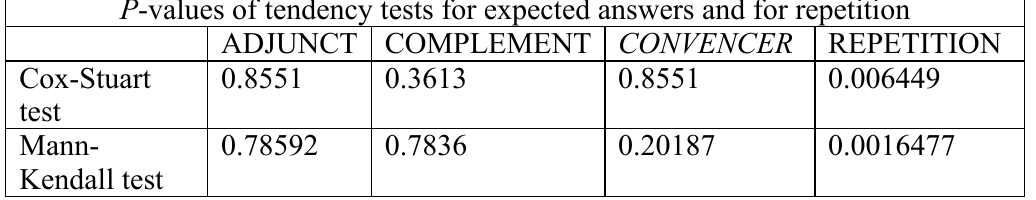
Table 2 . Expected answers per sentence type and repetition along the experiment: p-values of tendency tests